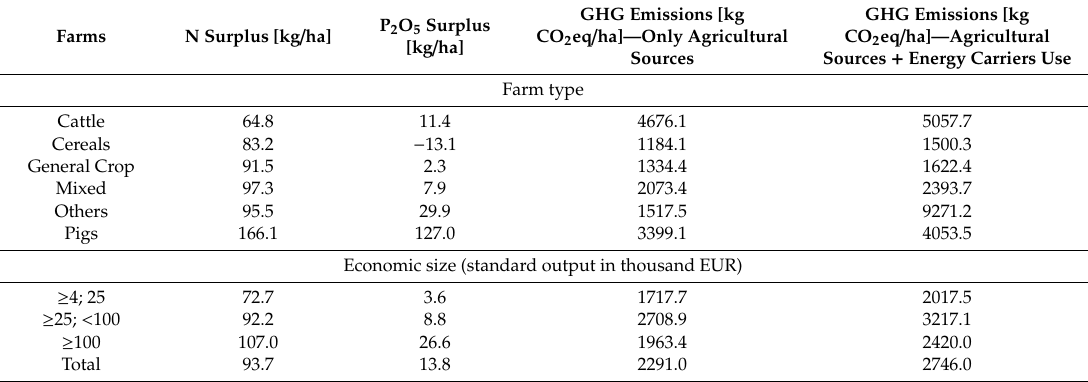
Table 2. Nitrogen and phosphorus surpluses and greenhouse gas (GHG) emissions per 1 ha of agricultural land by farm type and economic size in the sample of Polish commercial farms. GHG Emissions [kg P 2 O 5 Surplus CO 2 eq / ha]—Only Agricultural Farms N Surplus [kg / ha] [kg / ha]